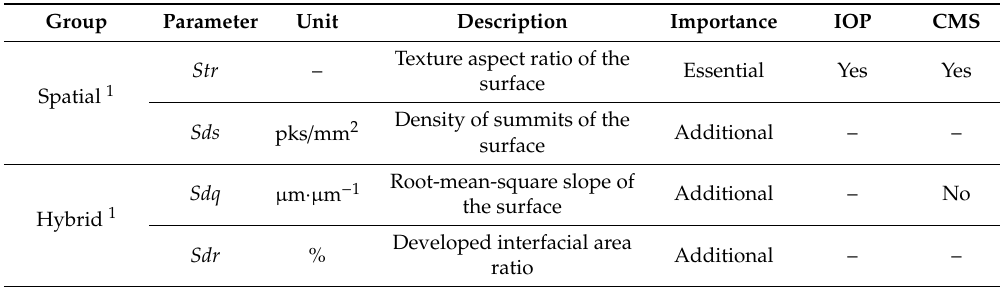
Their height (given by St amplitude parameter) was in a level ~15–16 µm (samples B1-1 and B1-3—Figures 8a and 8c, respectively) and ~5–6 µm (sample B1-2—Figure 8b). A comparison of the results of the analyses, presented in graphical form with the values of surface texture parameters, is listed in Figure 10a–c (top). It can be noticed that for the cutting edge of sample B1-2, the lowest values were obtained ( Sa = 2.17 µm, St = 30.4 µm, and Str = 0.03 µm). The Sds spatial parameter was also characterized by lower values, whereas for two hybrid parameters ( Sdr and Sdq ), higher values were obtained. The sign of the Ssk amplitude parameter indicated the predominance of peaks comprising the surface. In regard to the above, the sample B1-2 can be considered as regenerated in